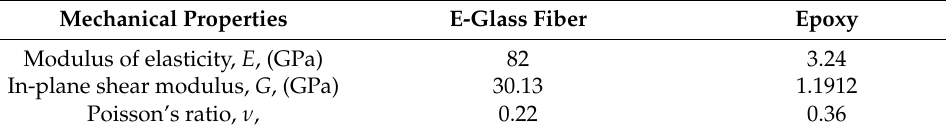
Table 2. The mechanical properties of E-glass fiber and epoxy resin.